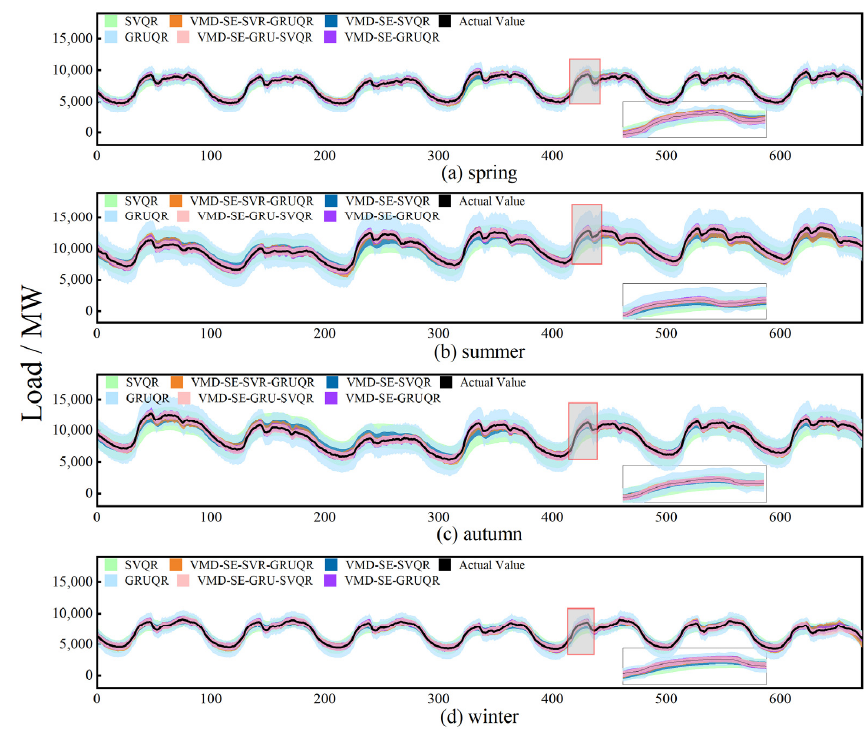
Figure 10. Forecasting results of dataset B at 90 confidence level.